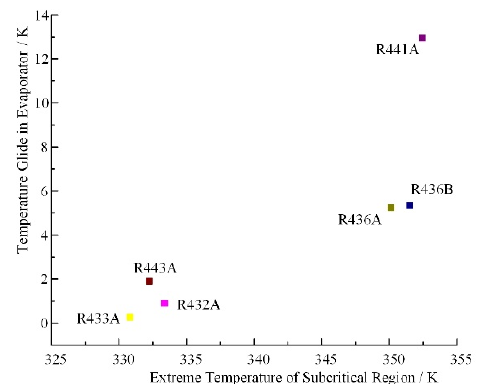
Figure 7. Relation between the temperature glide in condenser and the extreme temperature of subcritical region.